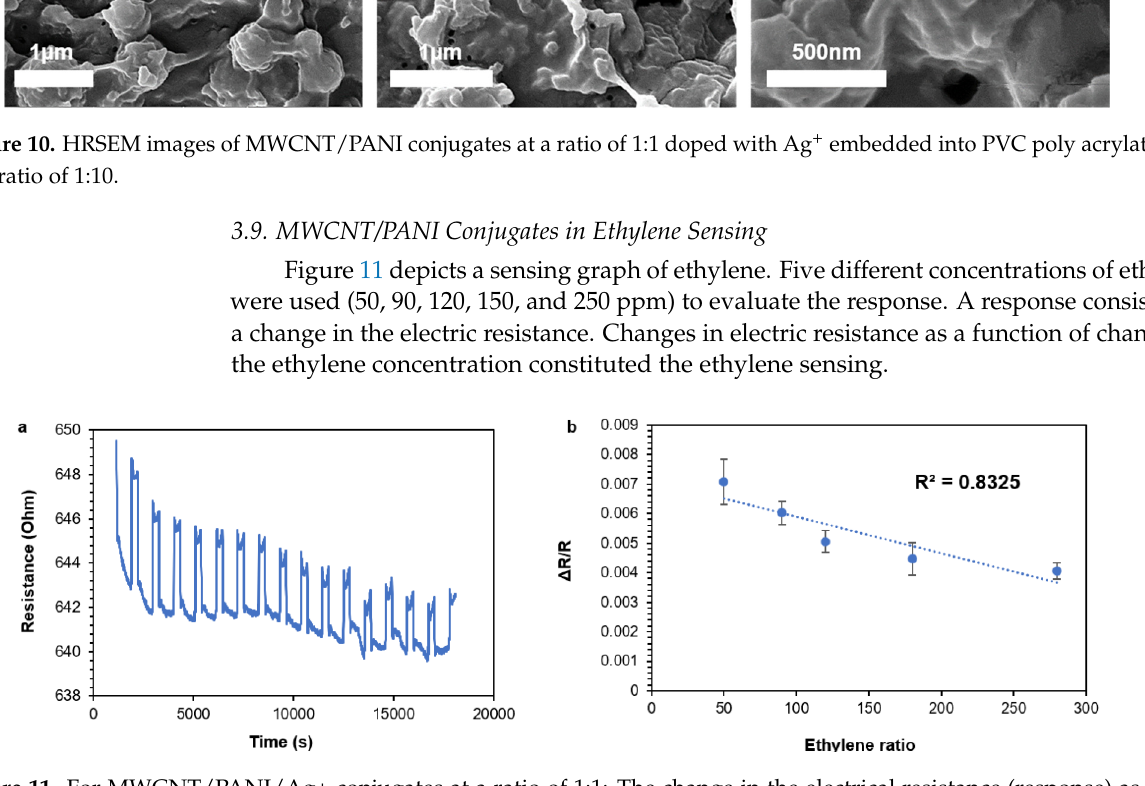
Figure 11. For MWCNT/PANI/Ag+ conjugates at a ratio of 1:1: The change in the electrical resistance (response) as a function of the ethylene concentration for low to high concentrations ( a ) and Δ R/R as a function of the ethylene ( b ).